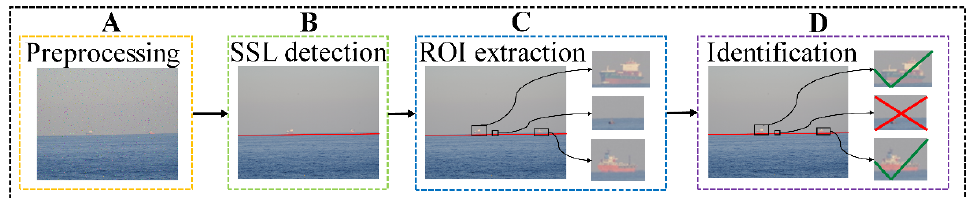
Figure 3. Workflow of the traditional ship detection method in marine environments. ( A ) Preprocessing. ( B ) SSL detection. ( C ) ROI extraction. ( D ) Identification.